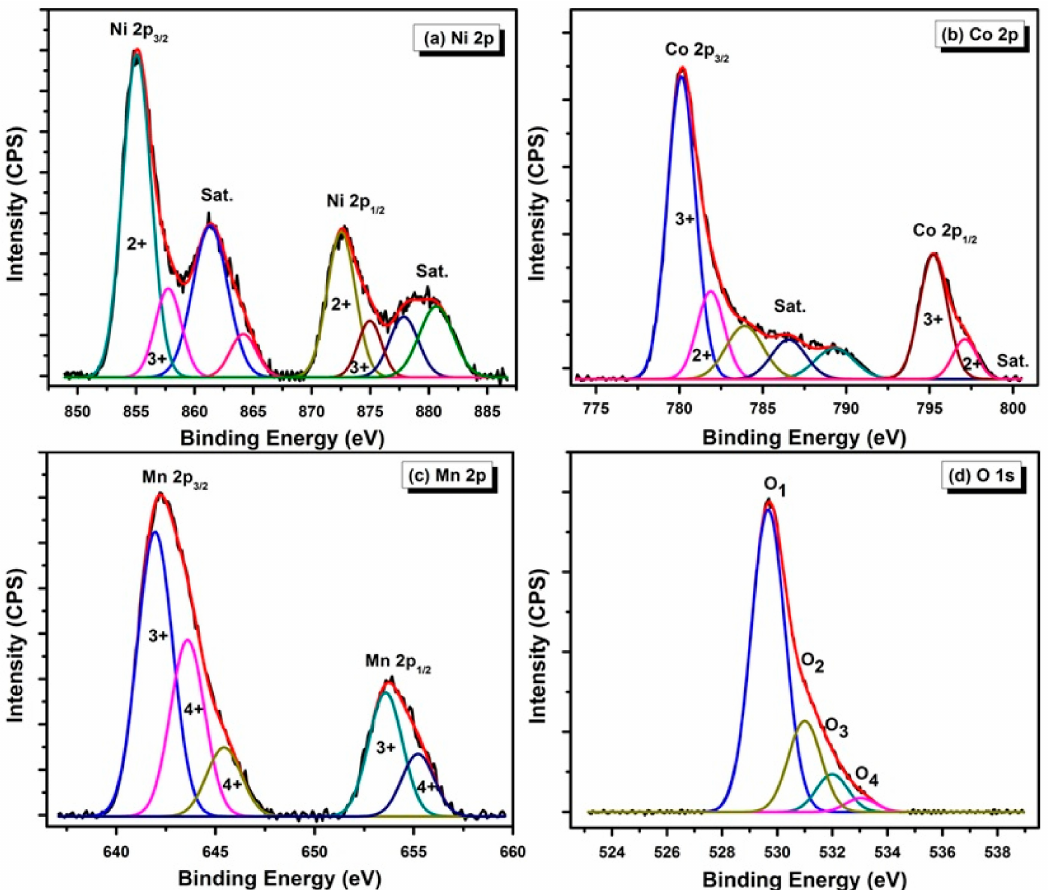
Figure 7. ( a ) High-resolution Ni 2p spectrum; ( b ) high-resolution Co 2p spectrum; ( c ) high-resolution Mn 2p spectrum and ( d ) high-resolution O 1s